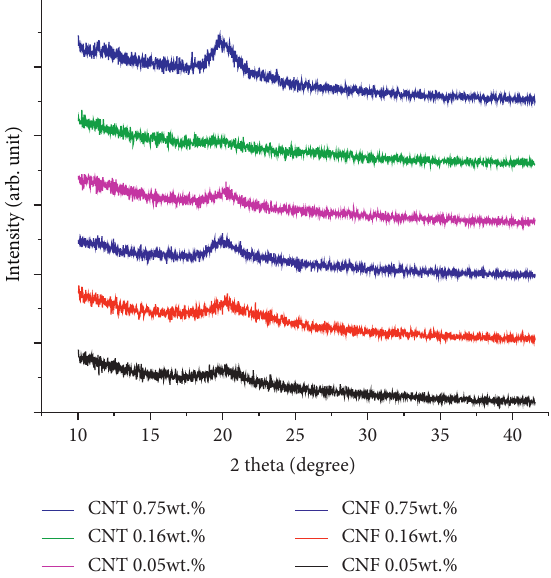
Figure 3: XRD spectra of (a) CNF and (b) CNT dispersed PVDF.